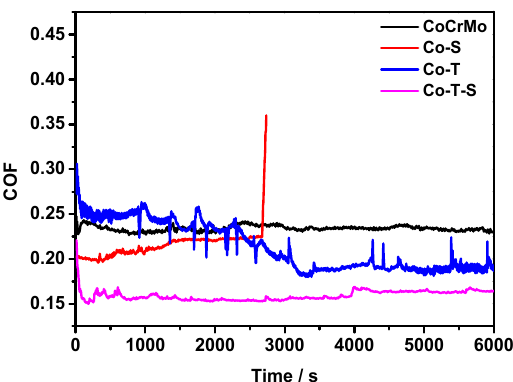
Figure 6. Variations in the friction coefficient of the flat, dimpled, and overgrafted specimens and the overgrafted dimpled specimens as a function of sliding time at a normal load of 2.4 MPa and a frequency of 2 Hz under BSA-lubricated sliding frequency of 2 Hz under BSA-lubricated sliding conditions.